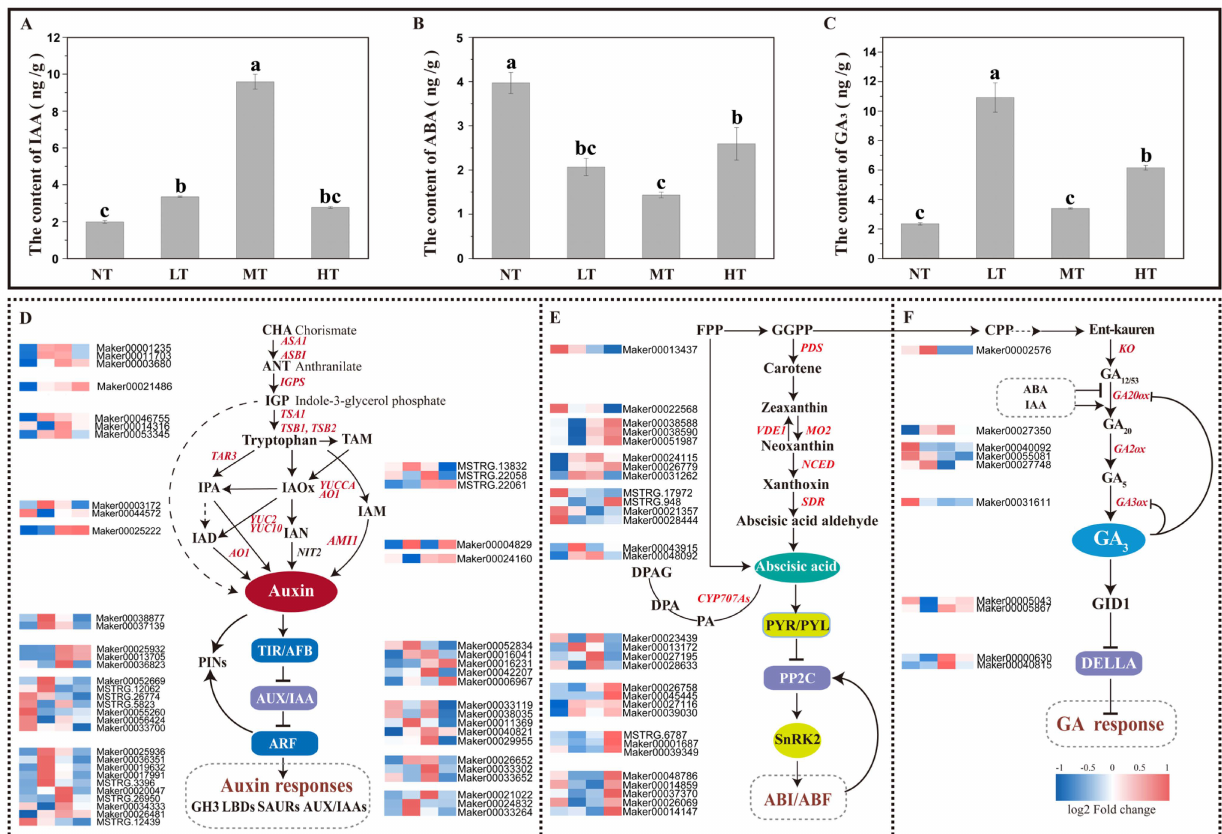
Figure 5. The concentration of ( A ) IAA, ( B ) ABA, and ( C ) GA 3 in the roots of the indicated groups. Data are mean ± SD of three biological replicates. The letters indicate significant differences (ANOVA, p ≤ 0.05). ( D – F ) show the gene expression pattern of IAA, ABA, and GA 3 biosynthesis and signaling in P. bournei roots from left to